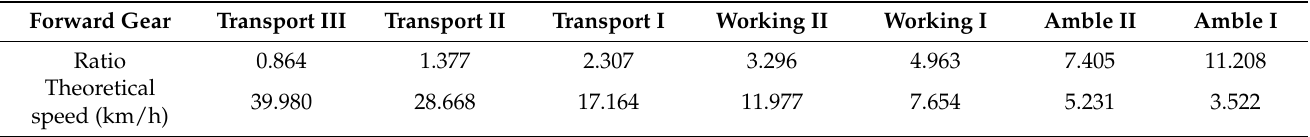
Table 2. Hybrid tractor transmission ratios and theoretical